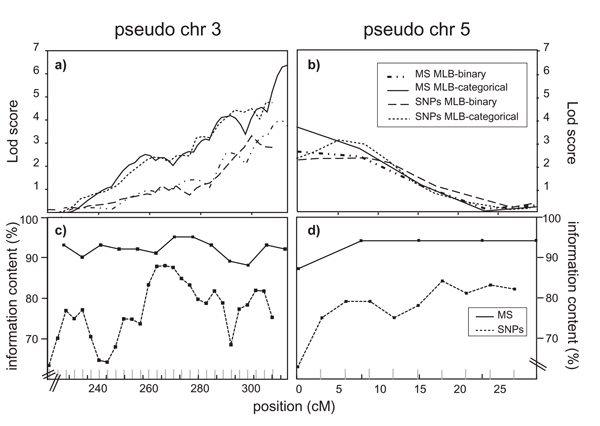
Multipoint LOD scores (a, b) and information content (%) (c, d) for the MS and the SNPs chromosome 3 (a, c) and chromosome 5 (b, d) regions for the affected-only strategy (MLB-binary) and the affected and unaffected strategy (MLB-categorical). The vertical lines on the x-axes of 1 c and 1 d are for the MS (black) and SNPs (gray) marker position. LOD and information content are provided at positions corresponding to MS and SNPs.